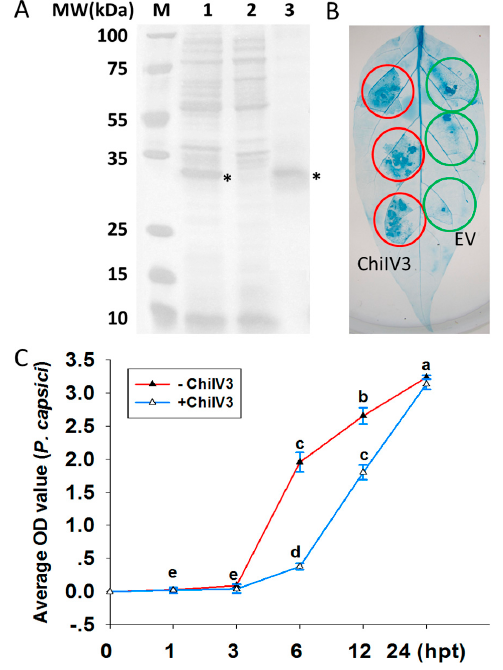
Figure 3. Prokaryotically expressed ChiIV3 inhibited the growth of P. capsici culturing in V8 medium. ( A ) SDS-PAGE assay was performed to confirm the expression level of ChiIV3 in Escherichia coli cells (BL21). The SDS-PAGE gel was stained with Coomassie Brilliant Blue (CBB) and scanned by a scanner. M, protein ladder marker; 1, pET32a-ChiIV3; 2, pET32a; 3, purified ChiIV3 protein. Asterisks represent the prokaryotically expressed ChiIV3 protein; ( B ) Trypan blue staining was performed to evaluate the cell death in pepper leaves triggered by purified prokaryotically expressed ChIV3 protein. Red and green circles indicate full and no cell death, respectively; ( C ) The purified prokaryotically expressed ChiIV3 suppressed the growth of P. capsici culturing in V8 medium. The P. capsici was first cultured in V8 medium, followed by supplemented with 500 ng prokaryotically expressed ChiIV3, and the OD 595 of P. capsici mycelia was measured at different time-points after treatment. Values are means ± SD ( n = 6). Hpt, hours post treatment. Different letters indicate significant differences determined by Fisher’s protected LSD test ( p < 0.05).